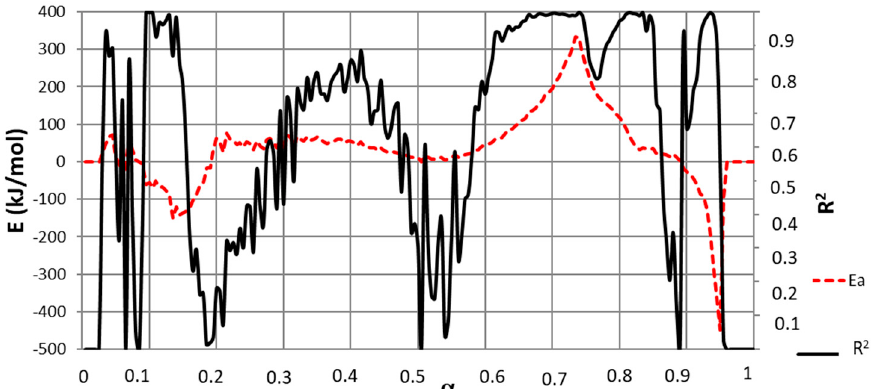
Figure 6. Common E with the Friedman method with a delay of α = 0.05 in both samples by using Equation (13).